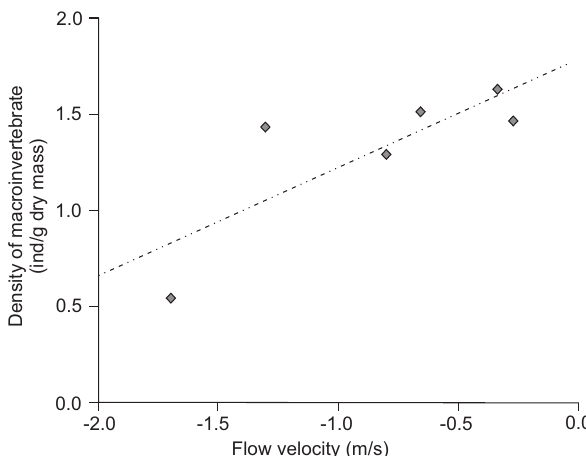
scale.Figure 2. Effect of flow velocity on mean density of individuals (ind./g dry mass) inhabiting stream bryophytes in the Poço D’Anta Biological Reserve. The axes are in logarithmic